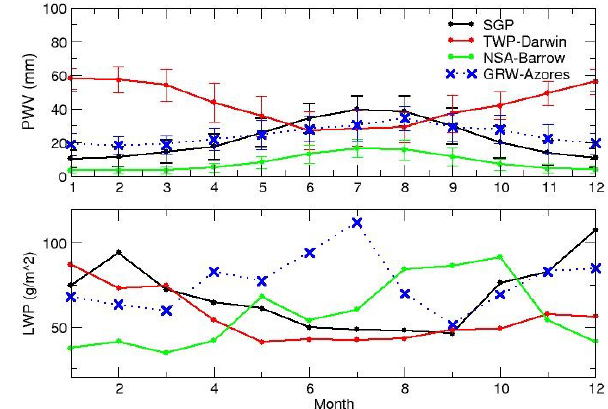
Fig. 9. Top: monthly PWV mean and standard deviation at the SGP (12yr, black), TWP (10yr, red), NSA (12yr, green), and AMF1- Azores (1yr, blue). Bottom: LWP monthly median values at the same locations (only data with LWP > 0 were included in the com-